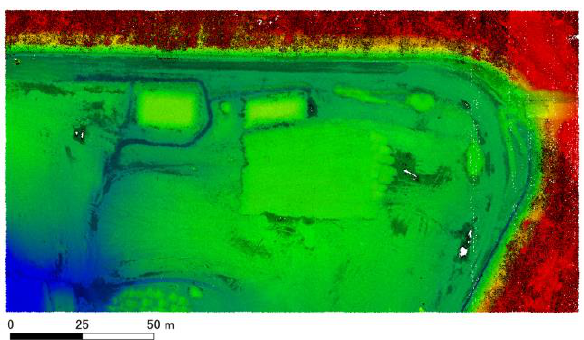
Figure 3. Tint map overlaid with laser reflection intensity Figure 3 is a tint map that was overlaid with laser reflection intensity such that the blue, green, yellow, and red colors represent intervals of 5 m for the data acquired up to 100 m as specified in setting 1. Comparing Figure 3 with the ortho-image in Figure 2, trapezoidal mounds were evidently observed near the center of the upper part of the figure, and a white area representing the missing data can be seen in several puddles. The wind speed on the ground was approximately 2.0 m/sec at the time of data acquisition, but the surrounding trees were swaying as a result of breeze, suggesting that stronger winds were occurring at greater